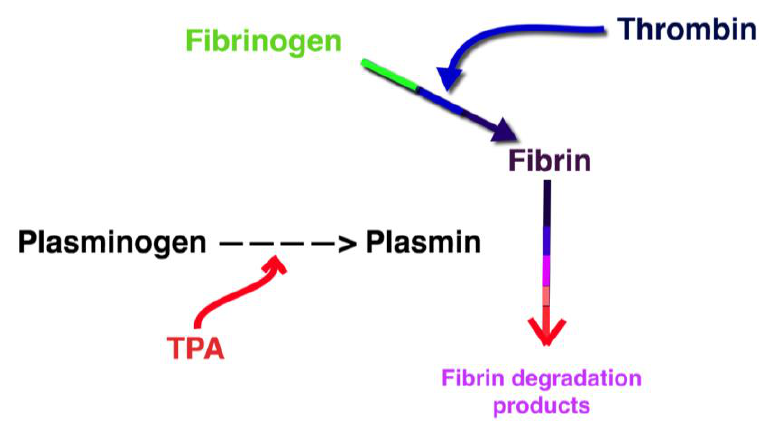
Figure 1. Fibrinogen degradation pathway. TPA: tissue plasminogen activator.